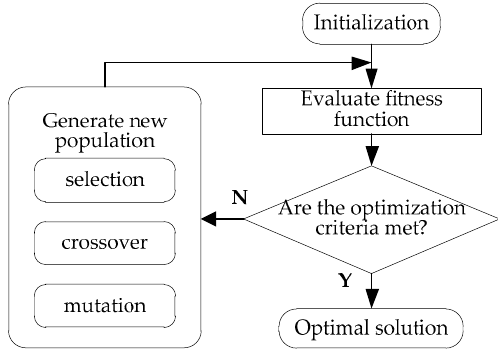
Figure 4. Basic structure of a Genetic Algorithm (GA).